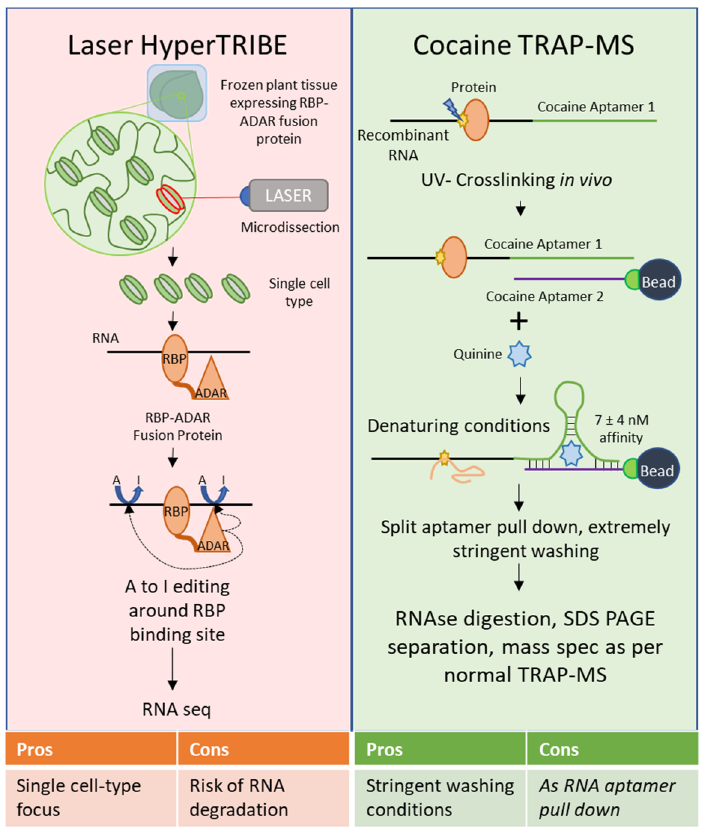
Figure 2. Proposed Modifications to Existing Techniques for Future Advancement. Laser HyperTRIBE—This is not a true modification to the HyperTRIBE approach itself, but rather a pairing of that approach with laser microdissection to enable the strengths of HyperTRIBE (capacity to accommodate small amounts of starting material) to be applied to plants. In this approach, intact plant tissue would be fixed prior to flash freezing, and then the cell types of interest selected via laser microdissection used for HyperTRIBE. Cocaine TRAP-MS—This modification suggests that rather than RNA aptamers that rely on protein binding capabilities, nucleotide-nucleotide aptamers should be prioritized. The split cocaine aptamer consists of two RNA fragments that interact at very high affinity in the presence of cocaine, or preferably quinine thanks to its increased affinity and ease of access. The high affinity of this interaction would permit extremely stringent washing conditions, which are critical in minimizing false